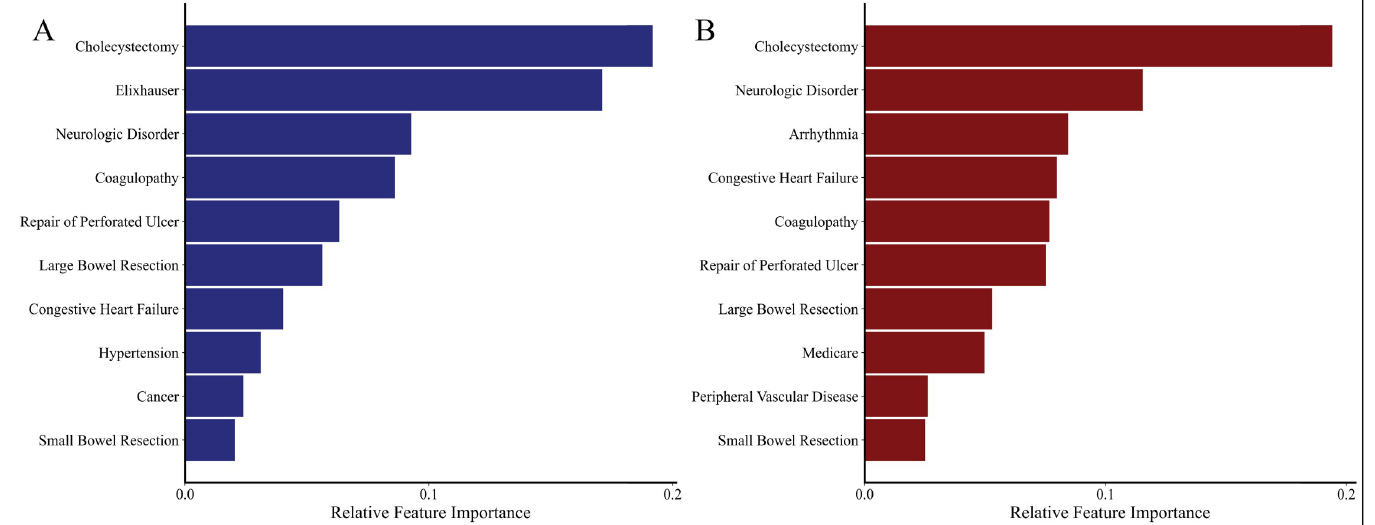
Fig 4. Feature importance of XGBoost model in predicting postoperative respiratory failure with (4A) and without (4B) the inclusion of the Elixhauser Comorbidity Index in models.